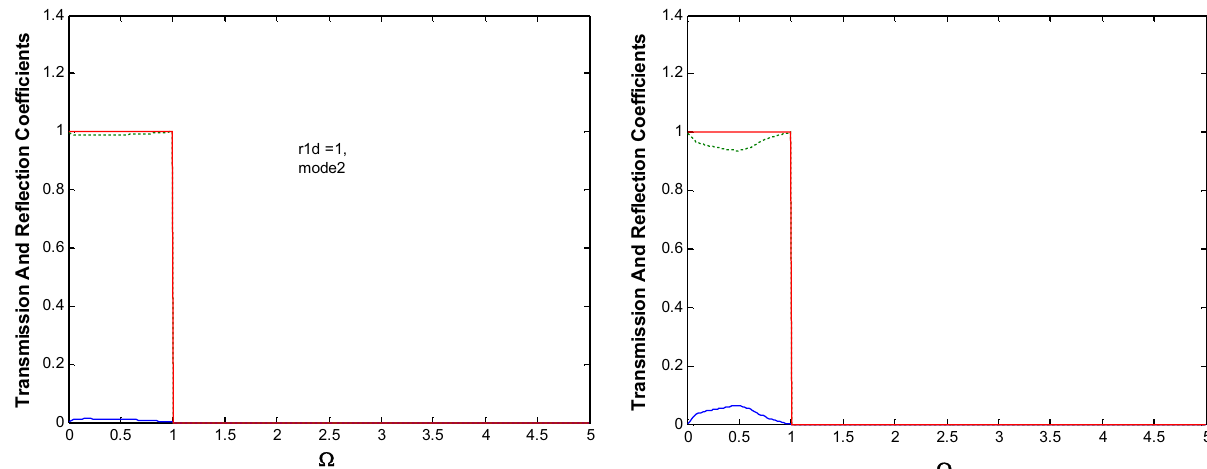
Figure 9: Transmission and re fl ection coe ffi cients in the case of homogeneous mode 2.